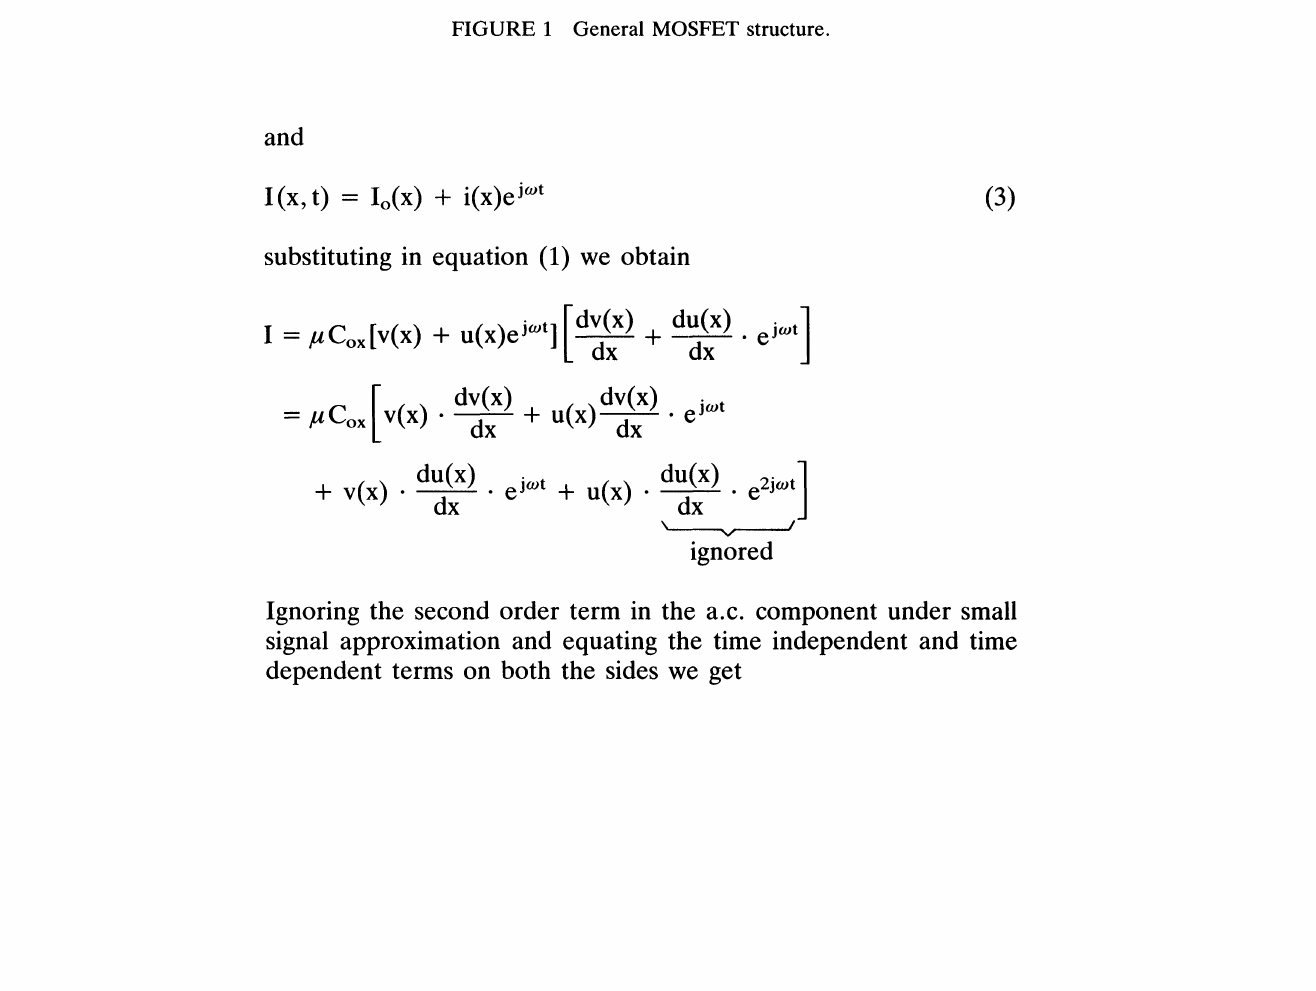
FIGURE General MOSFET